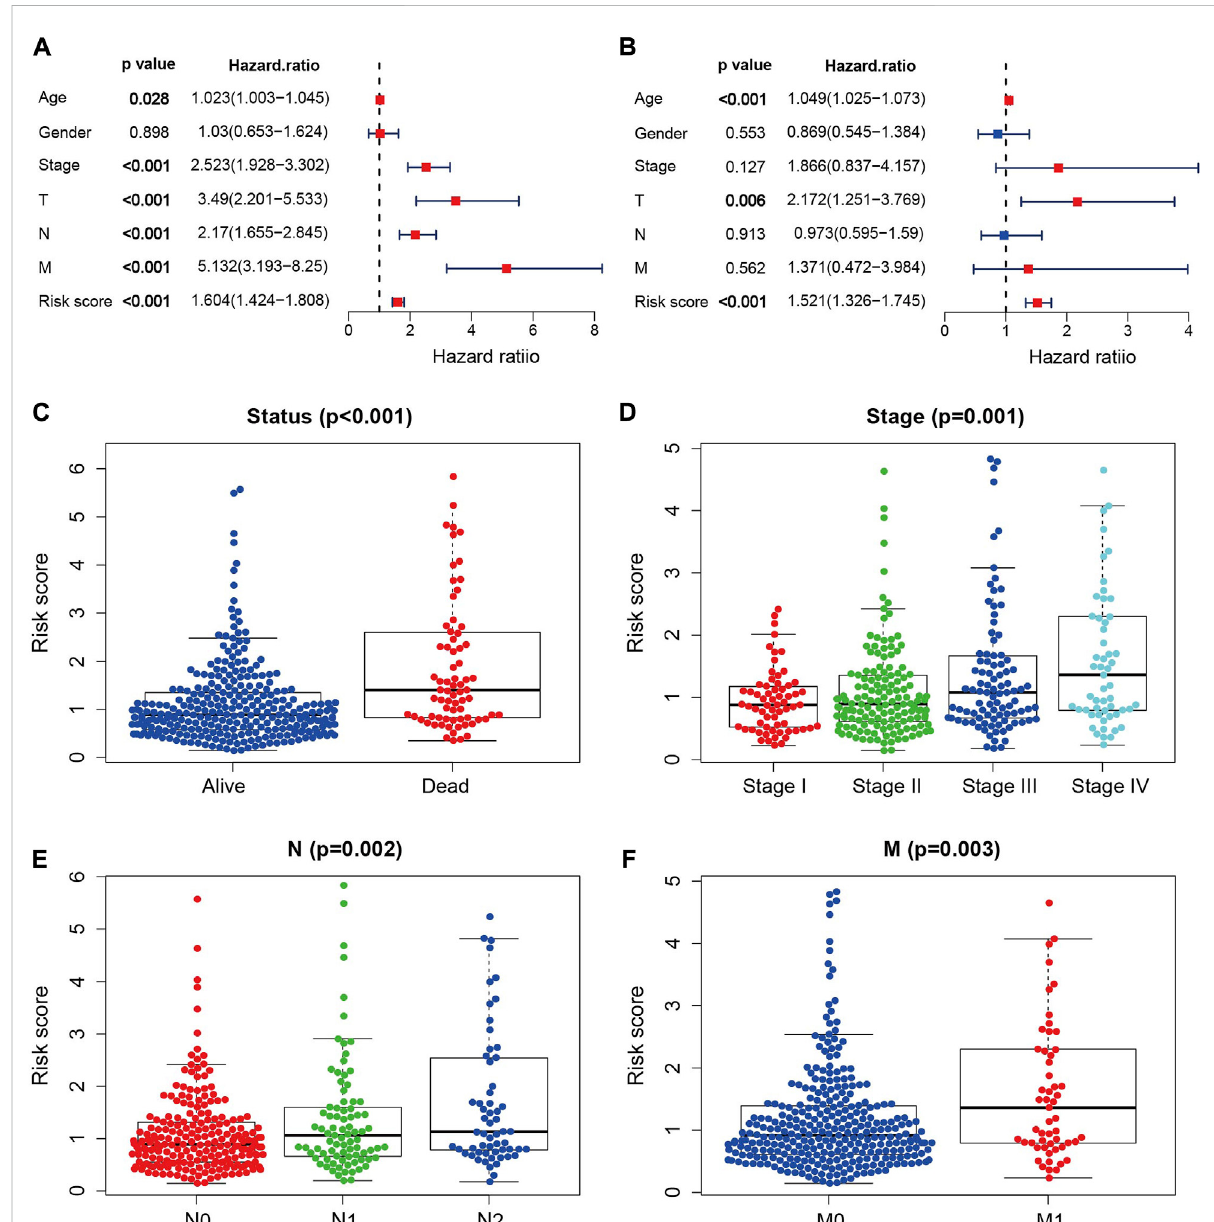
FIGURE 4 Independent prognostic analysis. (A) Univariate independent prognostic analysis in the TCGA cohort. (B) Multivariate independent prognostic analysis in the TCGA cohort. (C – F) NRGs signature based outcome strati fi cation of different clinicopathological features (Status, Stage, N,